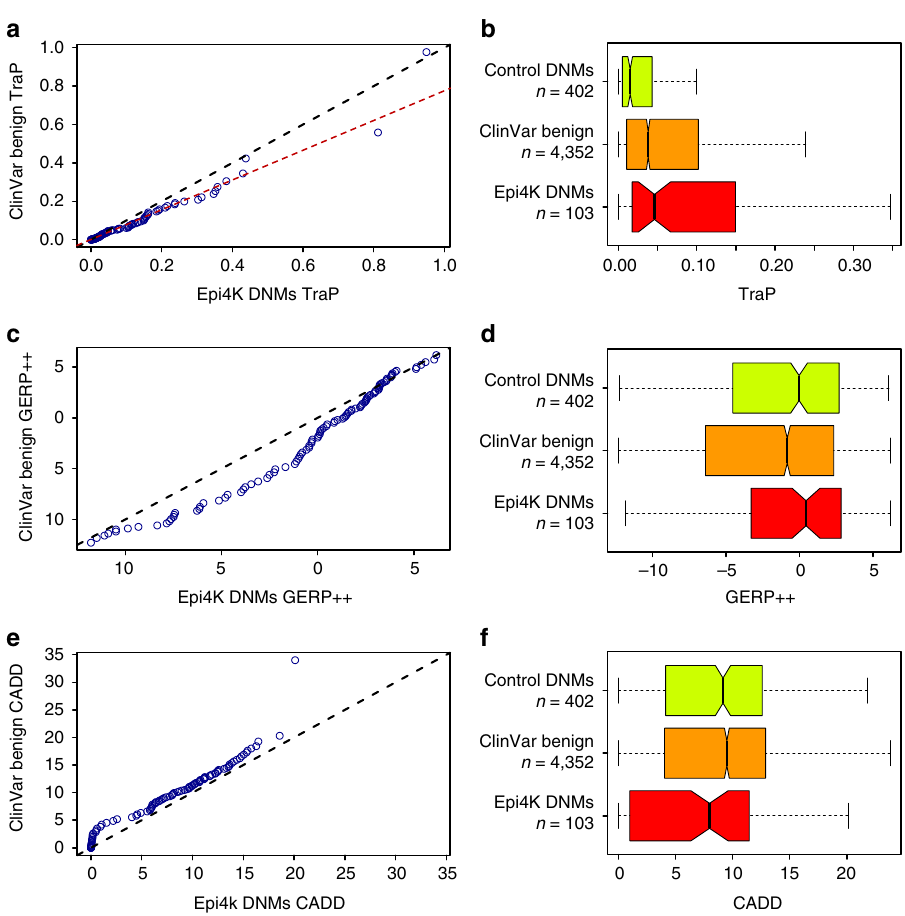
Fig. 4 Epilepsy synonymous DNMs vs. ClinVar benign controls. A quantile – quantile plot for 103 Epi4K DNMs and 4,352 benign ClinVar synonymous variants is calculated for a TraP scores, c GERP++ scores and e CADD scores. Score distributions for training-set control DNMs, ClinVar benign variants and Epi4K DNMs are scored using b TraP, d GERP++ and f CADD.The whiskers of the boxplots extend to the most extreme data point, which is no more than 1.5 times the interquartile range away from the